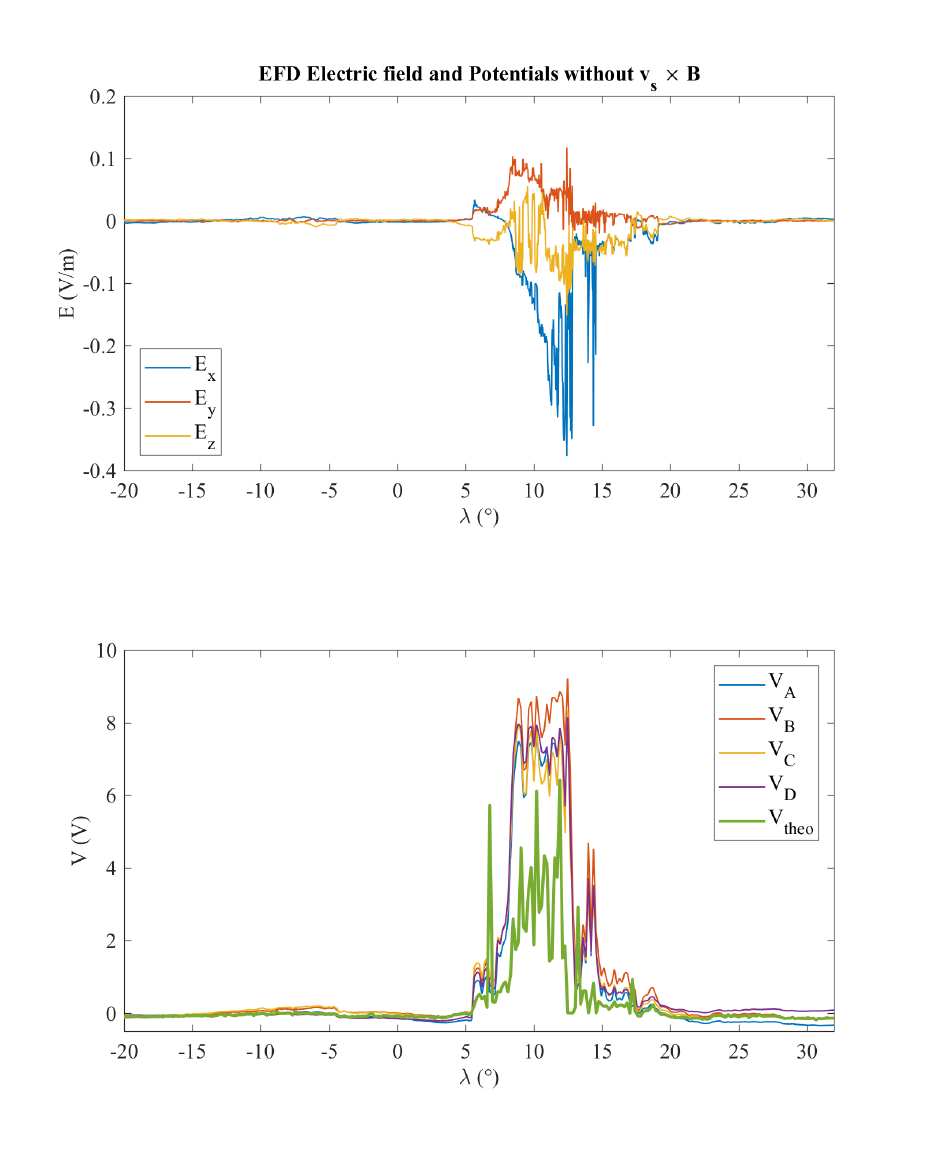
Figure 3. The upper panel shows the three component of the electric field on the nightside low latitude part of the CSES orbit n. 02930. The lower panel displays the four probes potentials along with the computed V theo (green line). λ is the geographic